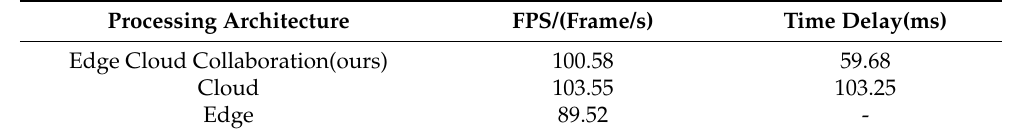
Table 3. Detection of frame rates for different processing